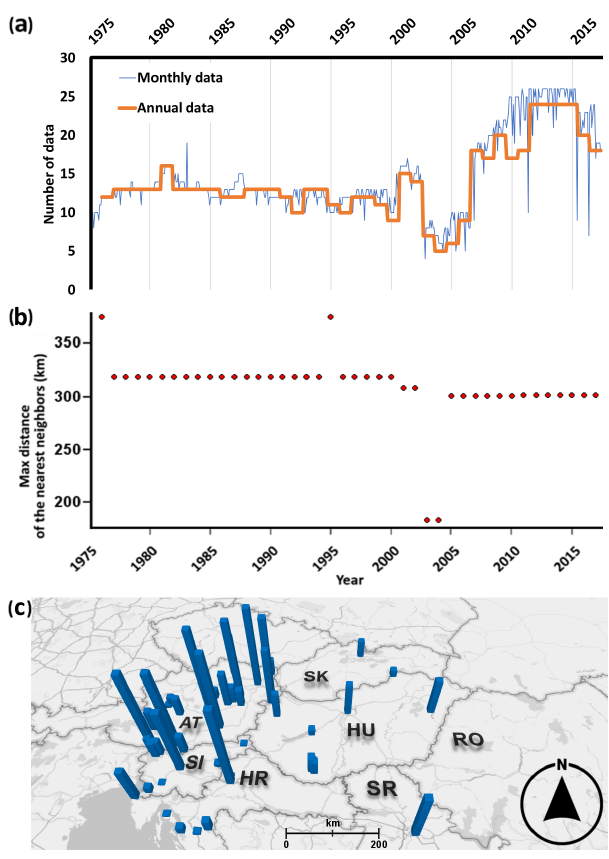
Figure 1. Temporal and spatial characteristics of the dataset. Num- ber of data from precipitation stations producing measurements of 3 H (1975–2017). (a) The thick orange line represents the number of stations applicable for computing amount-weighted annual precipi- tation averages later used in the interpolation (1976–2017). (b) The largest distance between the neighboring active stations of the stud- ied 3 H network in each year for 1976–2017. (c) Spatial distribution of the monitoring sites, where the height of the blue columns is pro- portional to the number of monthly data available between 1976 and 2017 at a given station; max = 479 data at Podersdorf, Austria. The country codes follow ISO-3166-1 ALPHA-2. The base map was taken from Bing maps, HERE Technologies